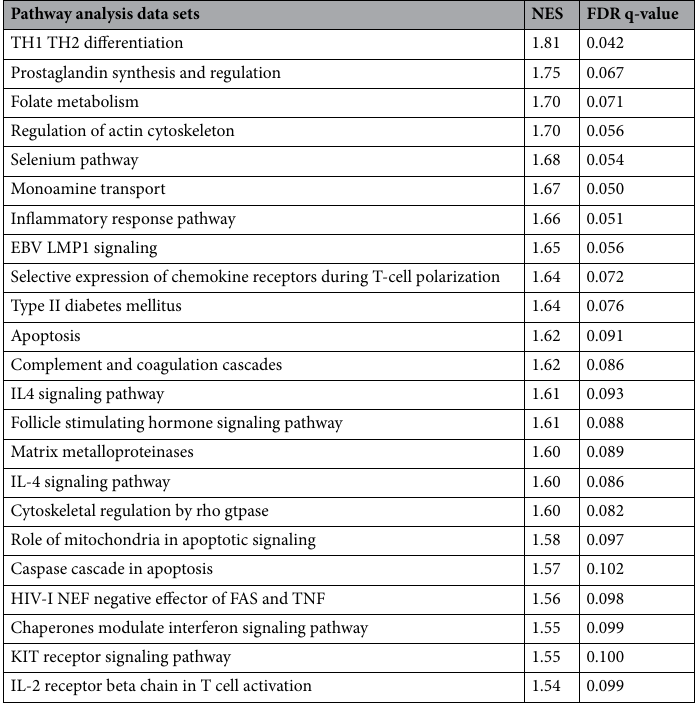
Table 2. Gene set enrichment analysis (GSEA) with pathway analysis data sets. FDR False-discovery rate, NES Normalized enrichment